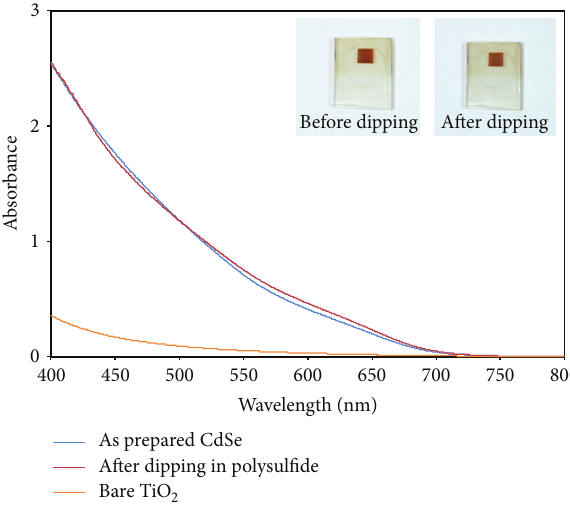
Figure 7: UV-vis spectra of CdSe-sensitized TiO 2 electrodes before and after dipping in polysulfide electrolytes (inset: photograph of CdSe-sensitized electrodes before dipping and after dipping in polysulfide